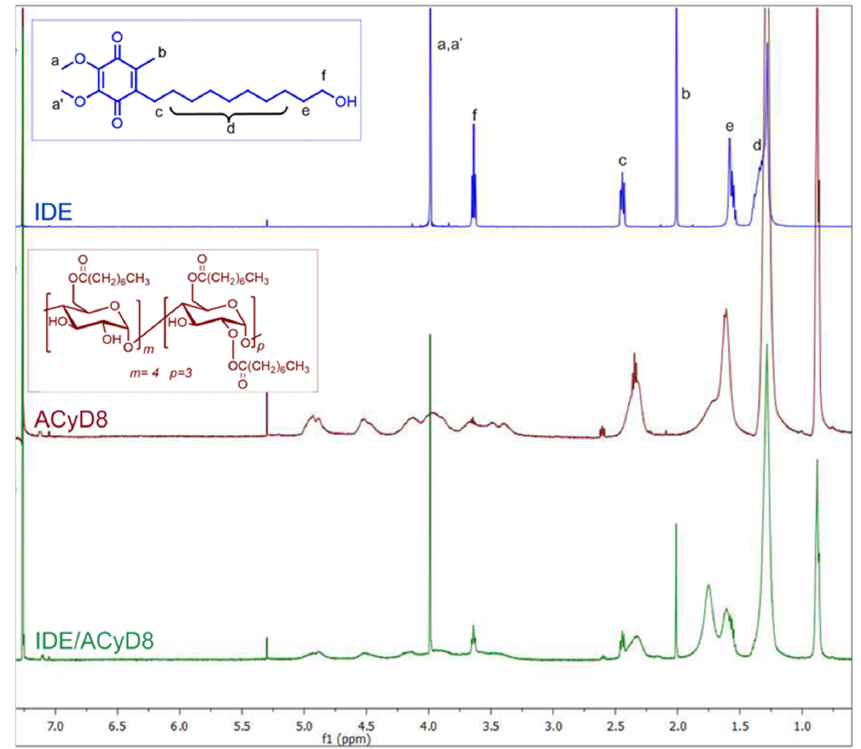
Figure 4. Stacked 1 H NMR spectra of free IDE (blue trace), ACyD8 (red trace) and IDE/ACyD8 (green trace). In the insets: chemical structures of IDE and ACyD8. Lowercase letters a – f were used for IDE proton assignment.